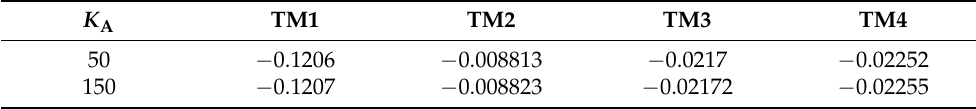
Table 4. Damping coefficient for TM1–TM4 of SG under different K A ( T A = 0.02).